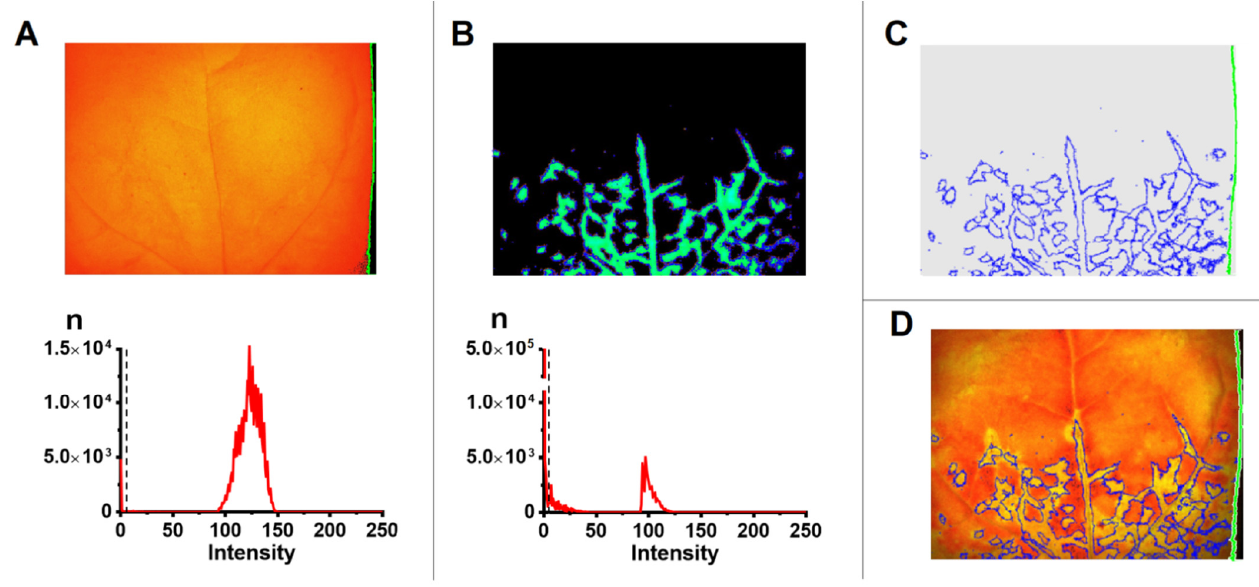
Figure 3. Determination of the infected, border and healthy areas in tobacco leaf images: ( A ) determination of leaf area in the image from chlorophyll fluorescence. The histogram of the signal intensity distribution is shown below. The dashed line in the diagram shows the intensity threshold above which a pixel in the image is defined as a leaf; ( B ) determination of the area infected with PVX-GFP. A fluorescence image of a PVX-GFP infected leaf ( λ ex 460 nm, λ em 500–540 nm) is shown above. The histogram of the signal intensity distribution is shown below. The dotted line in the diagram shows the threshold intensity value, above which a pixel in the image was determined as an infected area of the leaf. The histogram of the signal intensity distribution in a non-infected leaf is shown in Figure S1; ( C ) the outlines obtained in images ( A , B ); ( D ) distinction of the infected and healthy areas by superimposing of the outlines on the Φ PSII image of the same leaf.